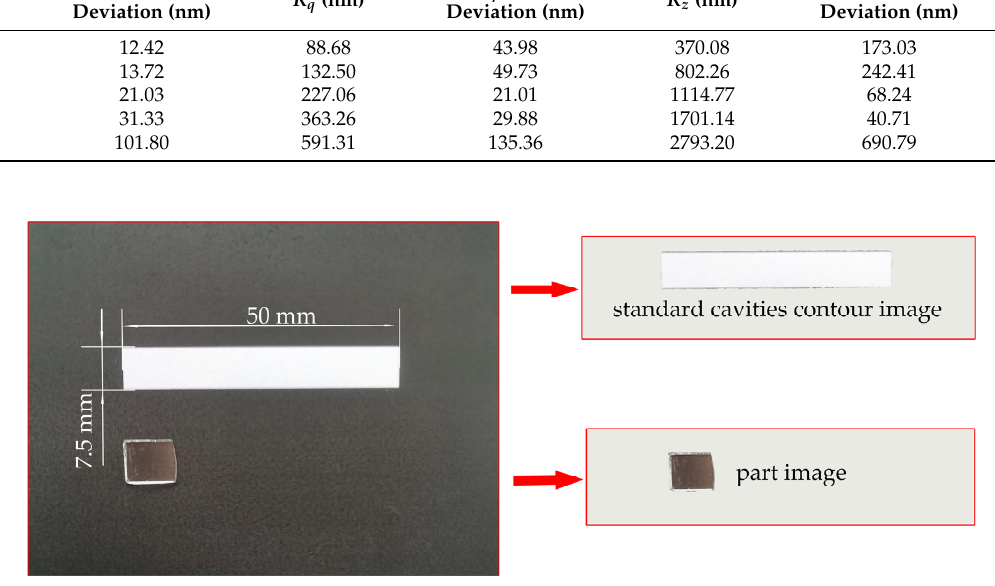
Figure 4. Schematic diagram of image processing.